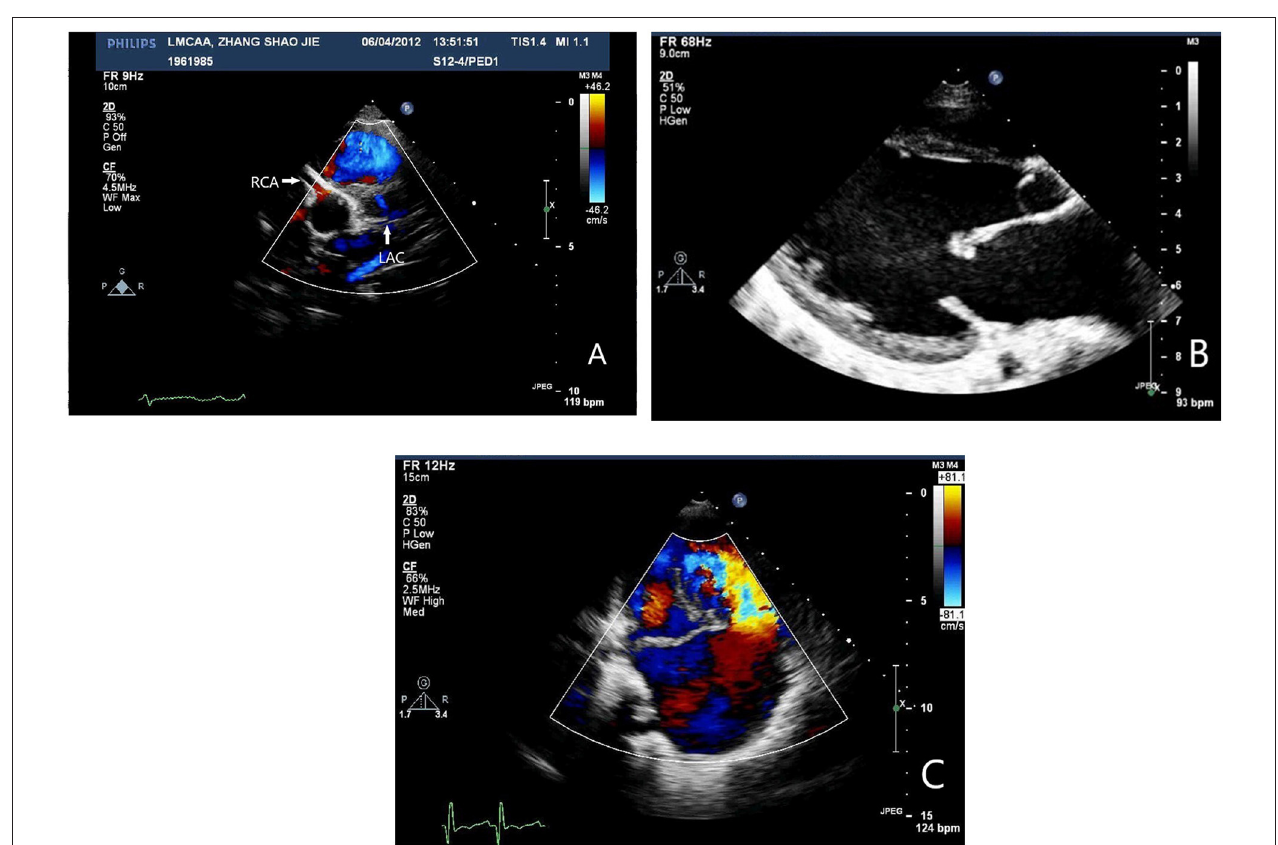
FIGURE 3 | (A) Echocardiography: No left coronary artery opening in the left coronary sinus, the origin and course of RCA is normal. RCA dilated the signal of reverse perfusion blood flow can be seen in the slender left main coronary artery. (B) Echocardiography: Echo enhancement of mitral valve, papillary muscle, and endocardium. (C) Echocardiography: Massive mitral